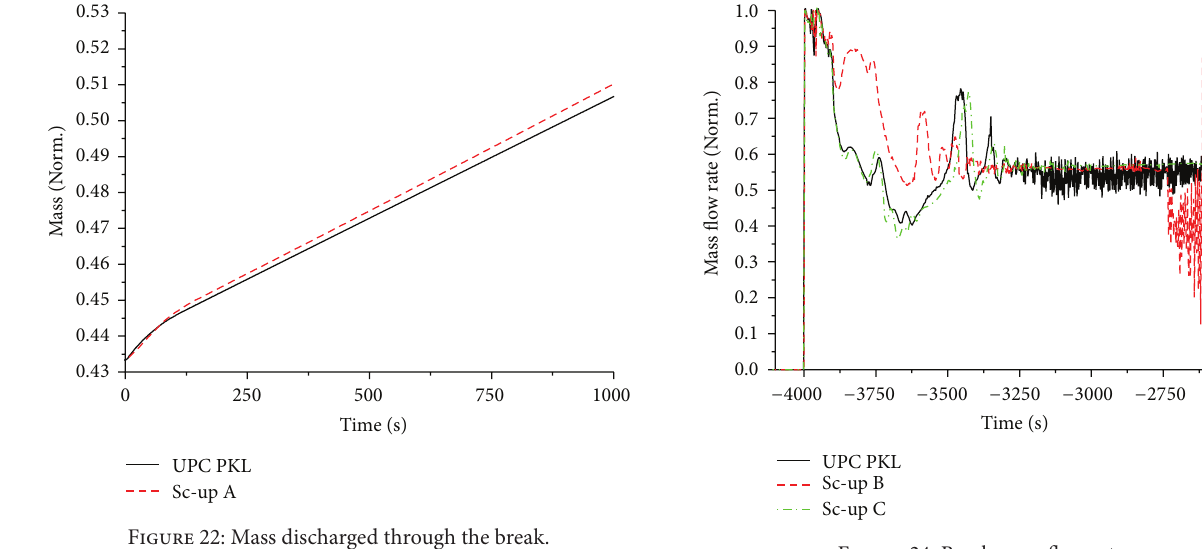
Figure 24: Break mass flow rate.